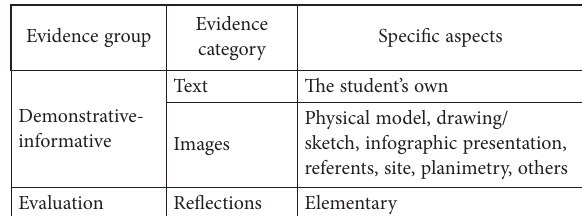
Physical model, drawing/ sketch, infographic presentation, referents, site, planimetry, others Evaluation Reflections Elementary It is possible to observe that the evidences are linked only to 2 groups (Demonstrative-informative and evalua- tion) and 3 categories (text, images and reflections). Oth- er groups and categories show values below 50